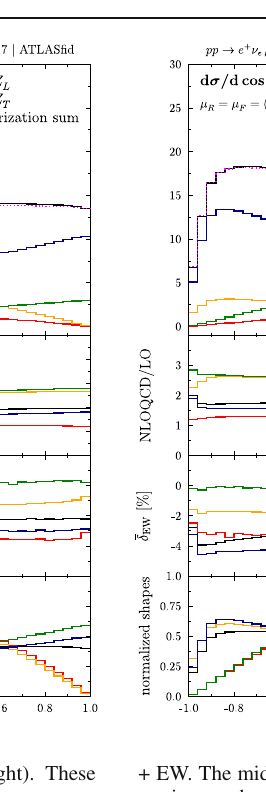
Fig. 3 Distributions in cos θ WZ + EW. The middle-up panel displays the ratio of the NLO QCD cross (left) and cos θ WZ μ − (right). These e + sections to the corresponding LO ones. The middle-down panel shows angles are calculated in the W Z center-of-mass system (more details ¯ δ are provided in the text), hence denoted with the W Z superscript. The EW , the EW corrections relative to the NLO QCD cross sections, in percent. In the bottom panel, the normalized shapes of the distributions big panel shows the absolute values of the cross sections at NLO QCD are plotted to highlight differences in